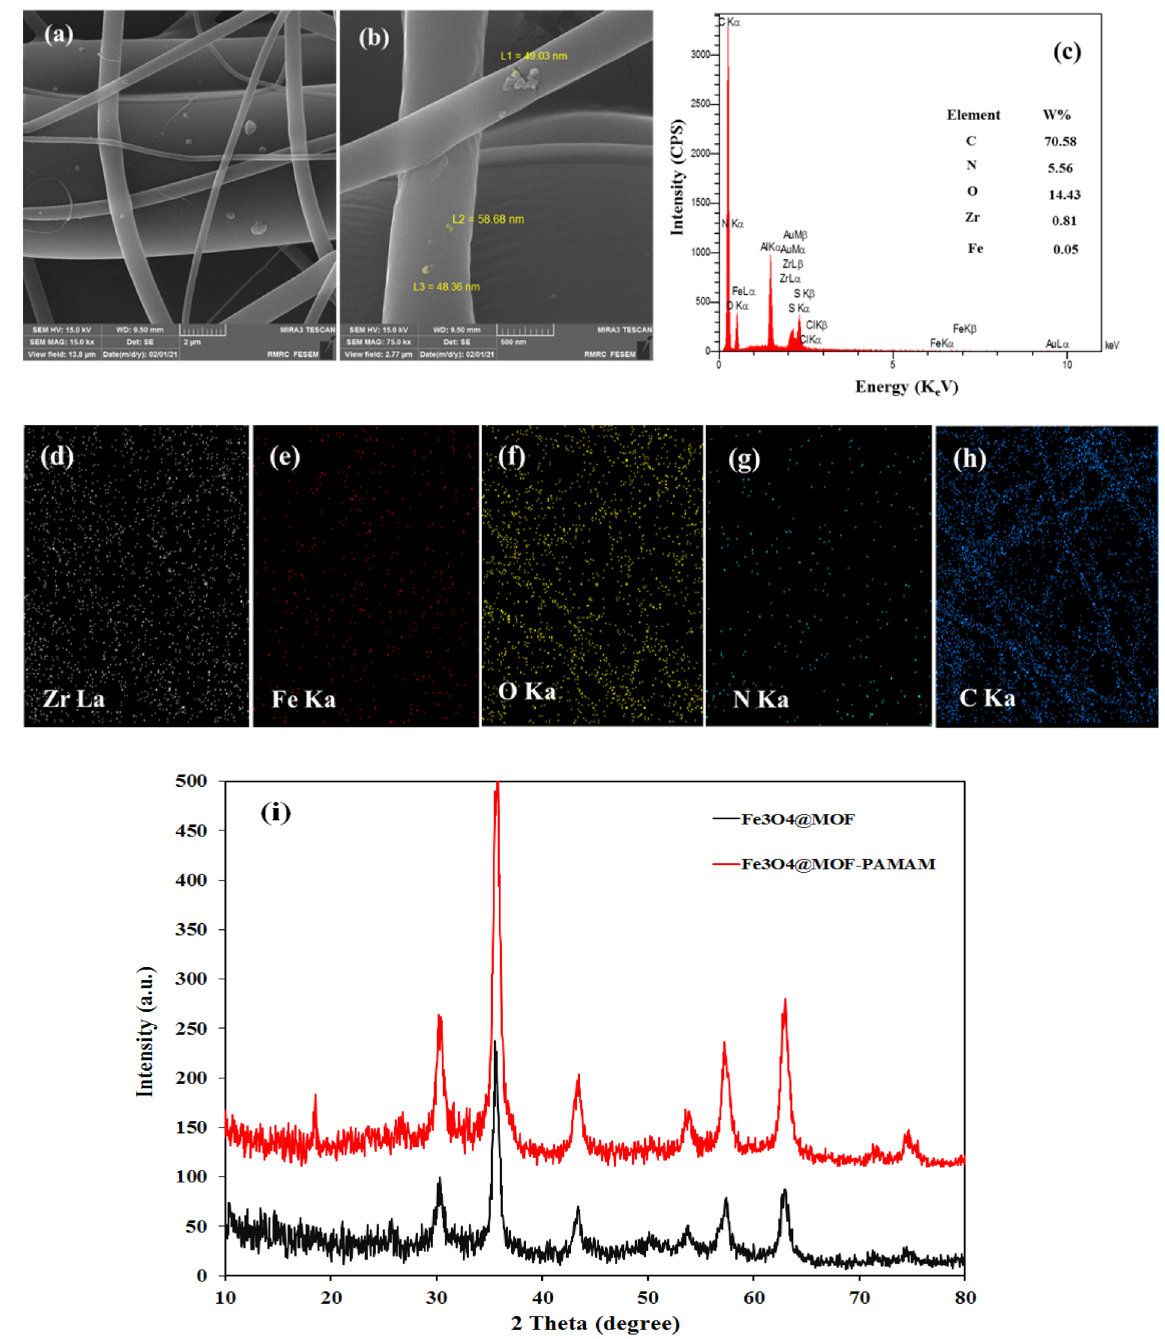
Figure 2. ( a , b ) FE-SEM images of the Fe 3 O 4 @MOF-PAMAM; ( c ) The EDS of Fe 3 O 4 @MOF-PAMAM; ( d – h ) The EDS-mapping of loaded